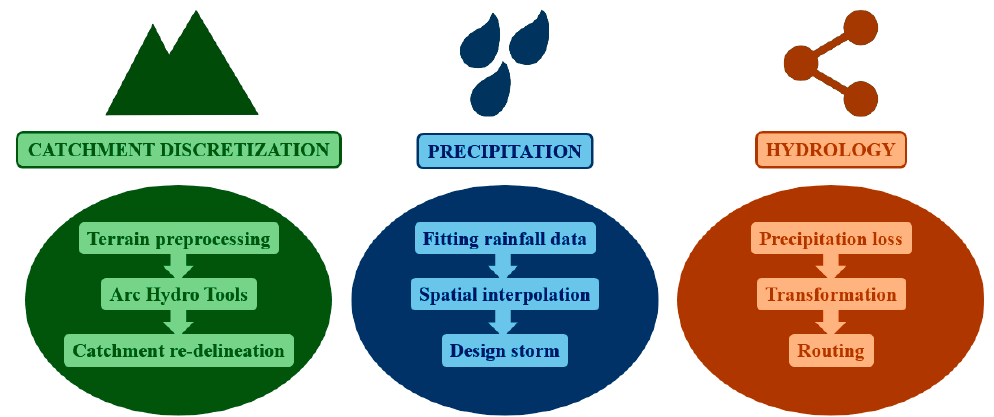
Figure 1. Breakdown of the proposed methodology into catchment discretization, precipitation and hydrology modules.